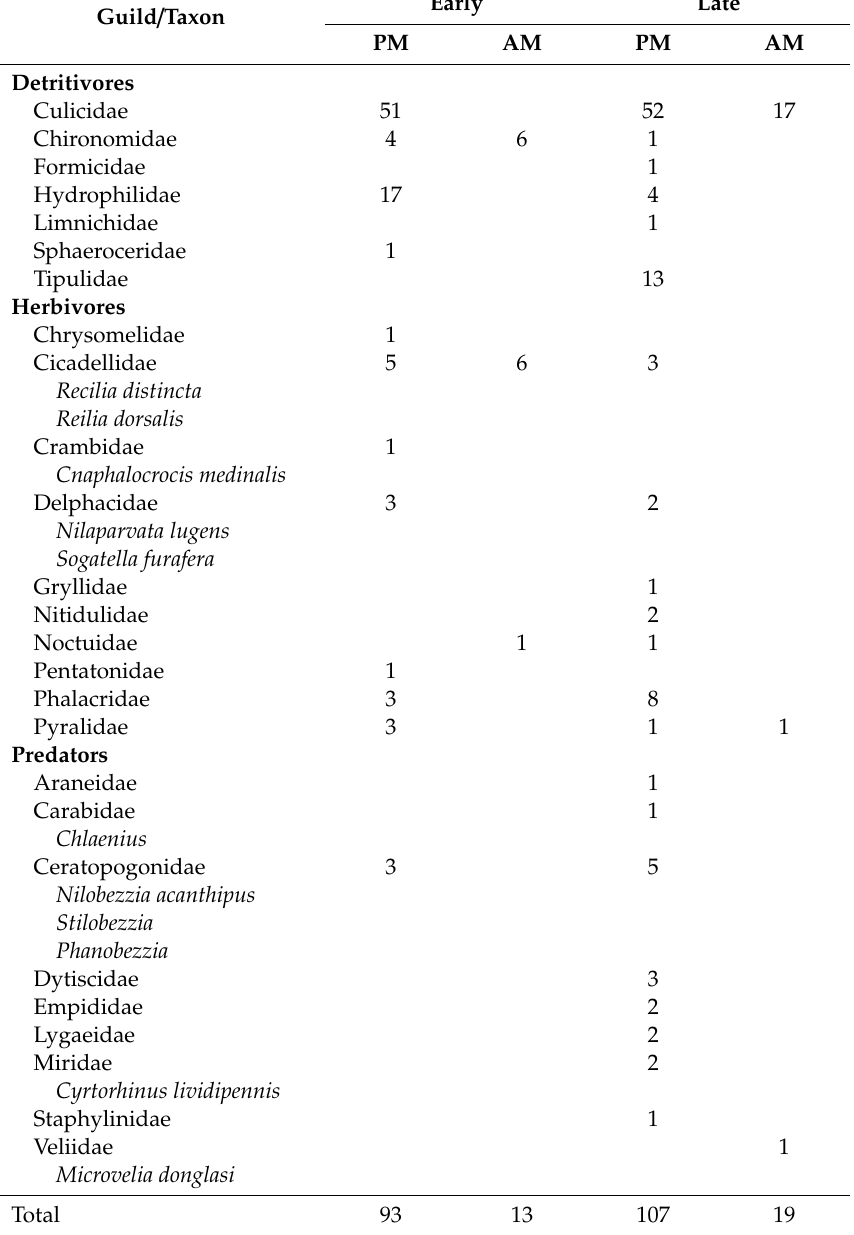
Table A2. Arthropod taxa captured by aerial sweep netting over early and late vegetative growth stage rice fields during the early evening (PM; 6 samples per stage) and just before sunrise (AM; 2 samples per stage). Numbers are given by family. Genera and species are given for important herbivores and